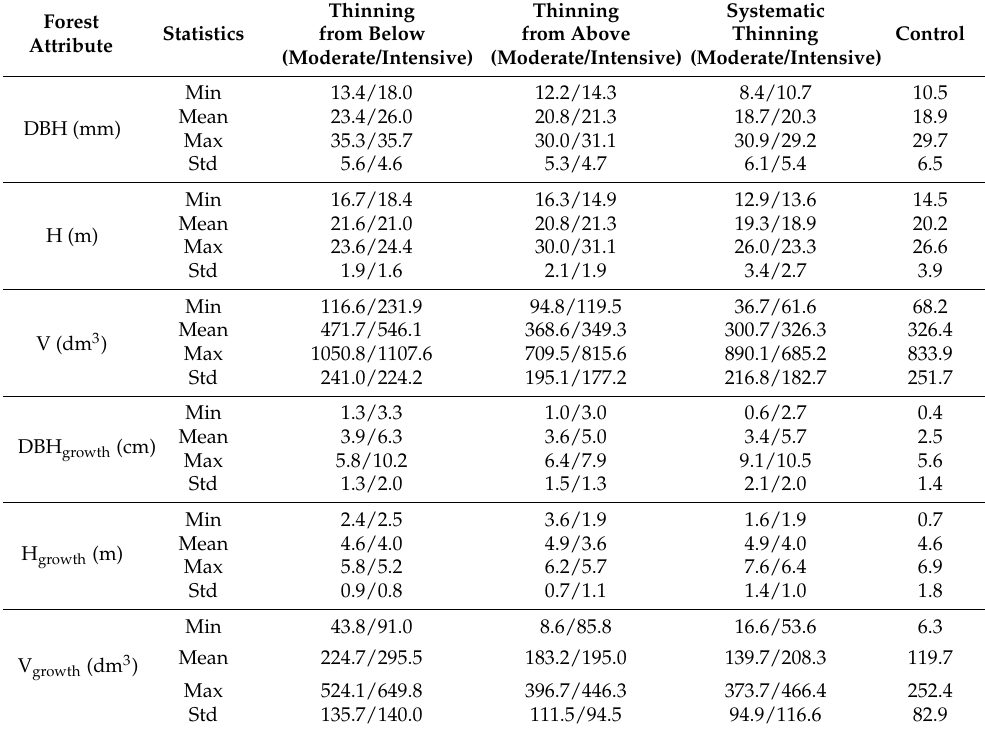
Table 3. Diameter at breast height (DBH), height (H), volume (V) and respective growth statistics for the 135 sample trees between different treatments. Tree-specific diameter (DBH growth ), height (H growth ) and volume (V growth ) increments for the last 12–13 growth seasons were calculated by the difference of TLS-derived DBH, H, g and V and respective field measured values during the study site establishment. Moderate refers to thinning guidelines applied in Finland [43] whereas intensive results in 50% lower remaining basal area (m 2 /ha) compared to moderate thinning. Control refers to plots without thinning treatments since the